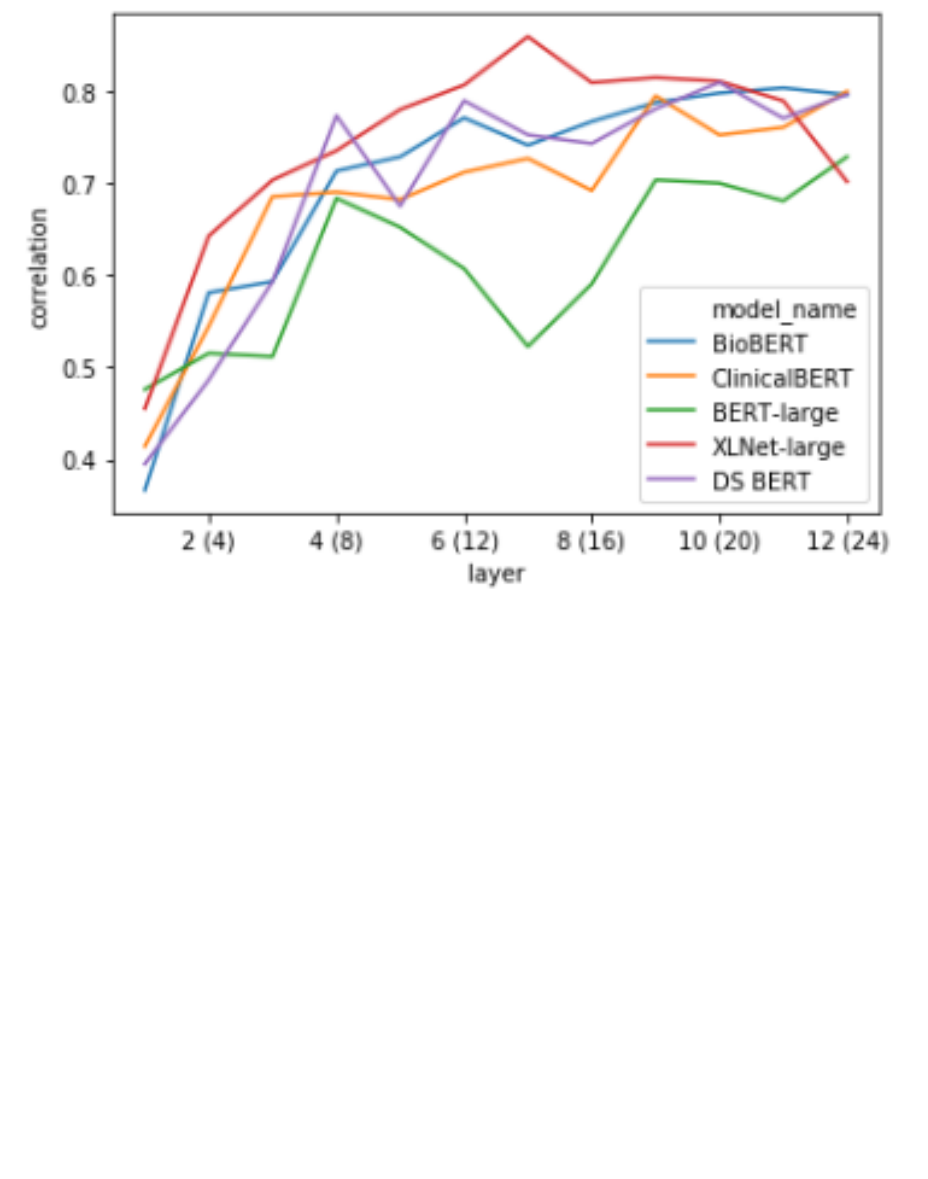
Figure 4. Pearson correlation between linear regression models’predictions of a sentence pair’s semantic similarity and the ground-truth score (10-fold cross-validated on test-set) using [CLS] token pair